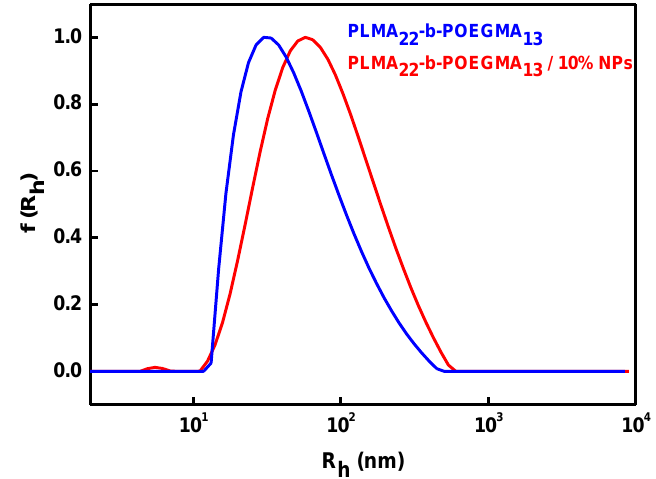
Scheme 1. Simplified schematic illustration depicting the preparation of the PLMA- b -POEGMA/NPs mixed nanostructures.